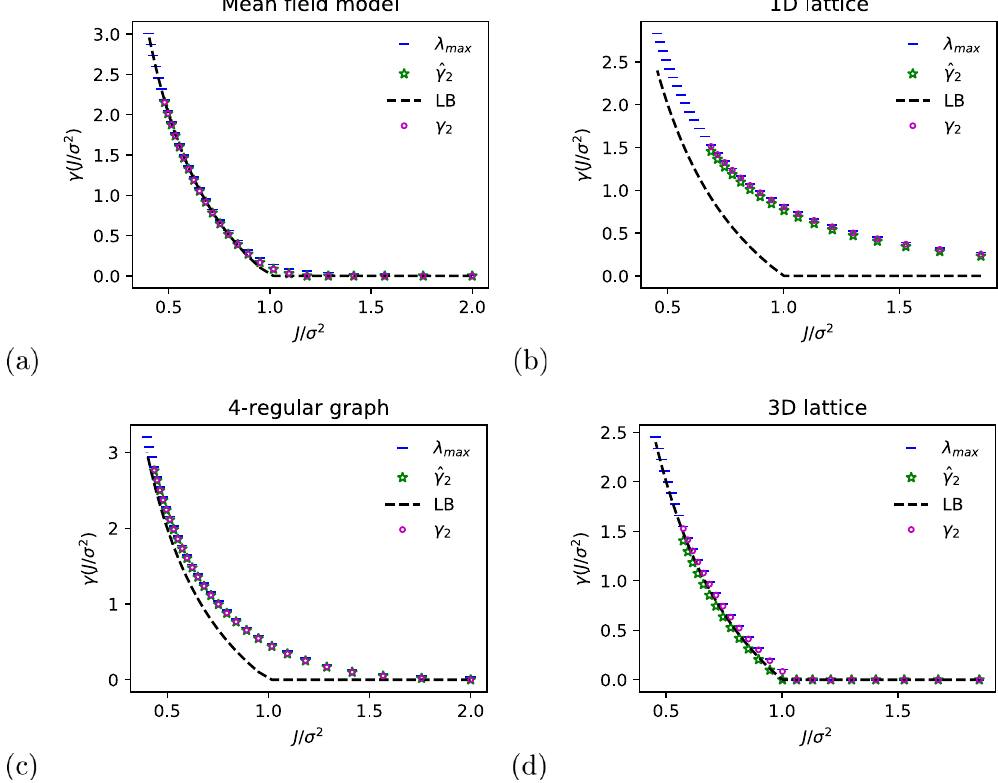
Figure 3. A numerical solution of the graph sample (green star) and moment (purple circle) Lyapunov exponents (Eqs (9) and (10)) and the largest eigenvalue of Eq. (12) (horizontal blue line) for four types of graphs: ( a ) Mean field ( b ) 1D lattice ( c ) regular graph of degree 4 ( d ) 3D lattice. The black dashed line represents the analytical lower bound presented in Eq.